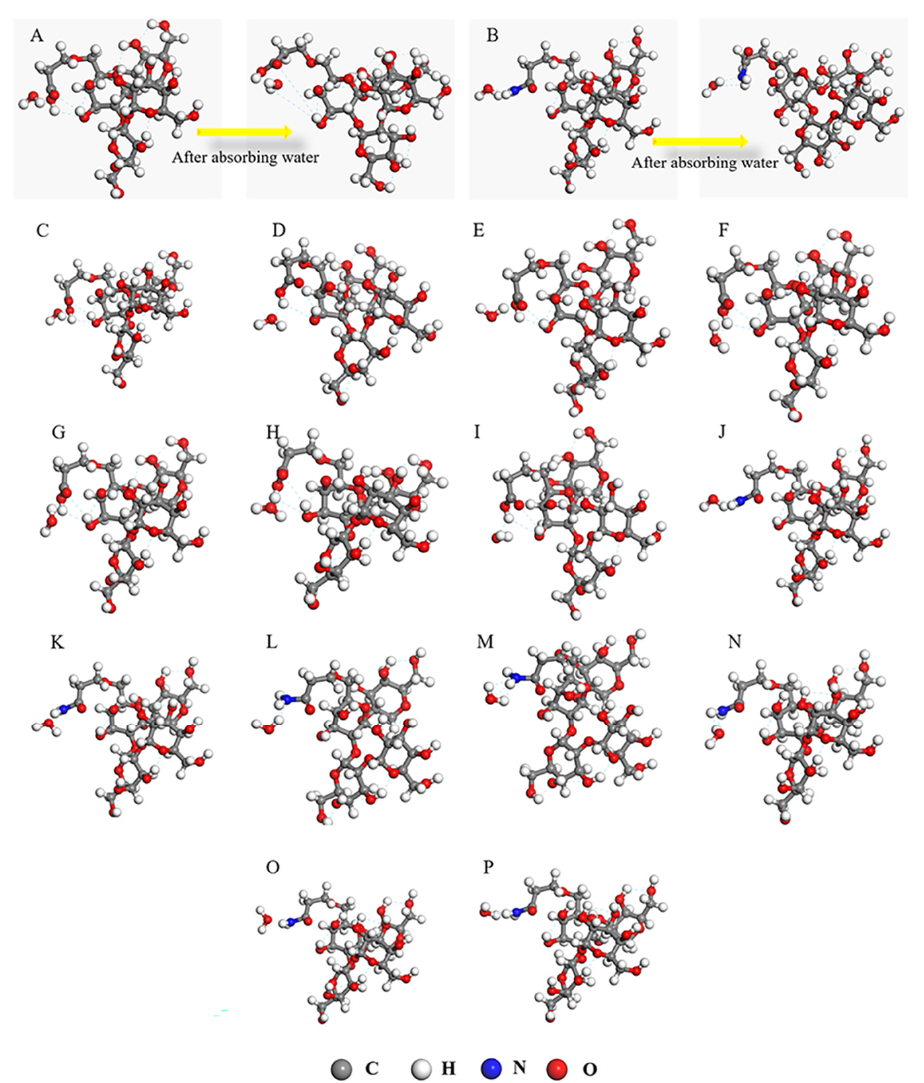
Figure 13. Structural changes in the adsorption of water molecules by carboxyl ( A ) and amino ( B ) groups in CAAMC branched chains and different configurations of adsorbed water molecules ( C – P ).